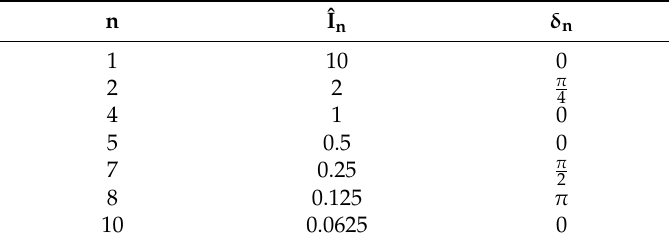
Table 1. Example values for Figure